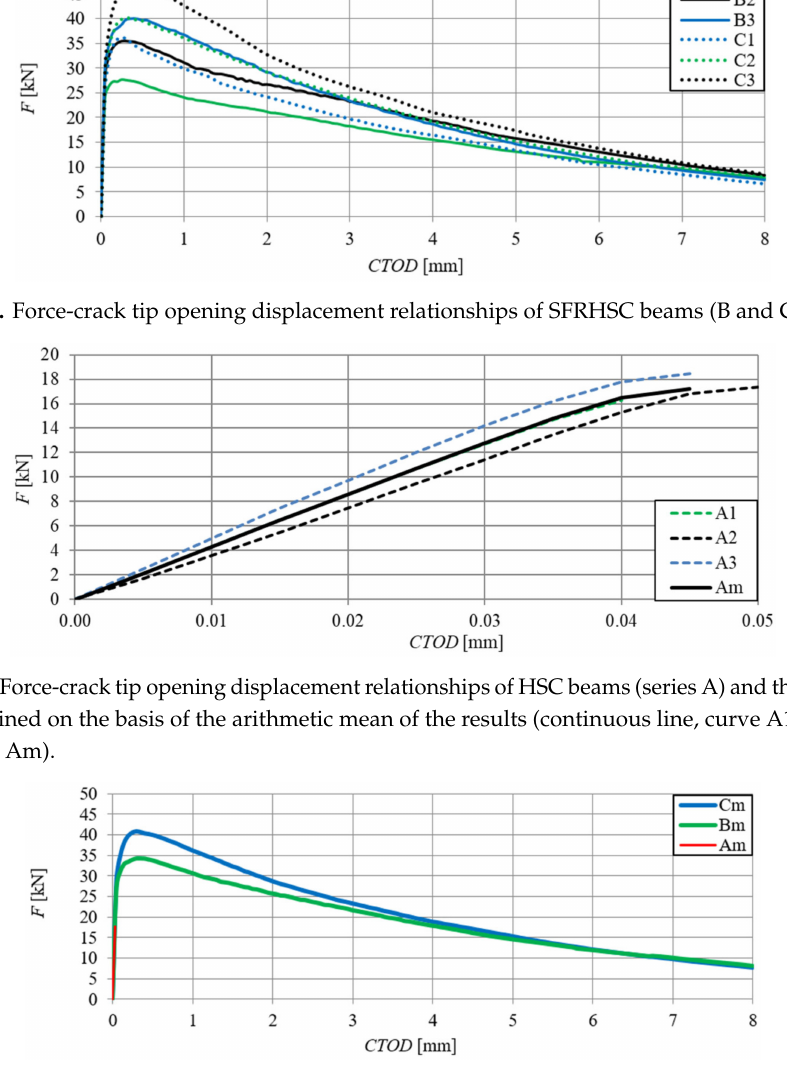
Figure 11. Force-crack tip opening displacement relationships obtained on the basis of the arithmetic mean of the results for beams in series A, B and